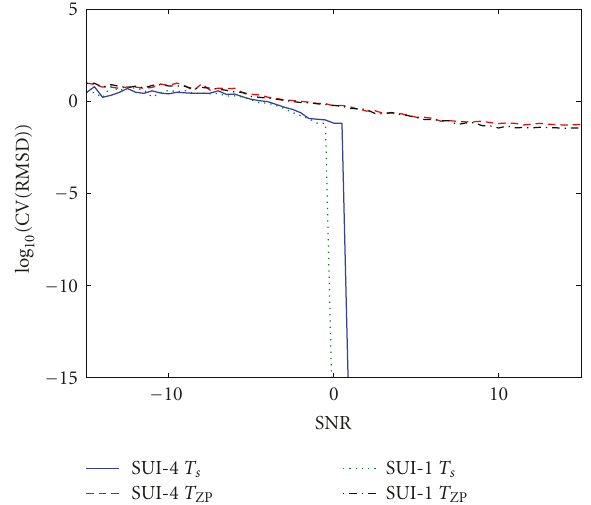
Figure 12: CV(RMSD) of the symbol duration T s and the ZP duration T ZP on SUI-1&4 channel models with